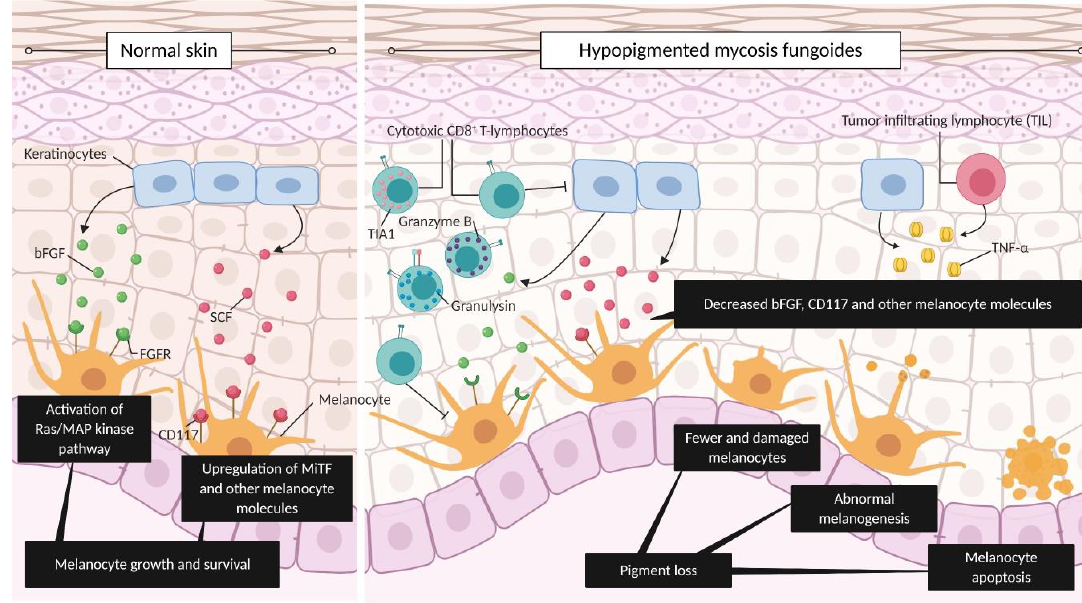
Figure 3. Hypopigmentation as a surrogate marker of antitumor immune response in mycosis fungoides (MF). In normal skin, keratinocytes produce basic fibroblast growth factor (bFGF) and stem cell factor (SCF). The binding of bFGF to FGF receptor (FGFR) in melanocytes activates the Ras / MAP kinase pathway, while the binding of SCF to its cognate receptor CD177 in melanocytes upregulates microphtalmia-associated transcription factor (MiTF) and additional melanocyte molecules, leading to melanogenesis. Both pathways lead to melanocyte growth and survival. In HMF, cytotoxic CD8 + lymphocytes, which act as part of the antitumor immune response, releasing granulysin and granzyme B, combined with the Th1 inflammatory response rich in TNF- α , result in damage to keratinocytes and melanocytes. This damage to keratinocytes leads to a decreased level of the melanocyte molecules bFGF and CD117, among others. Without the signals needed for melanocyte growth / survival and in the presence of granzyme B, granulysin, and TNF- α , HMF skin eventually has fewer and damaged melanocytes, abnormal melanogenesis, and apoptotic melanocytes. These features lead to the characteristic pigment loss of HMF. Figure created with BioRender.com.